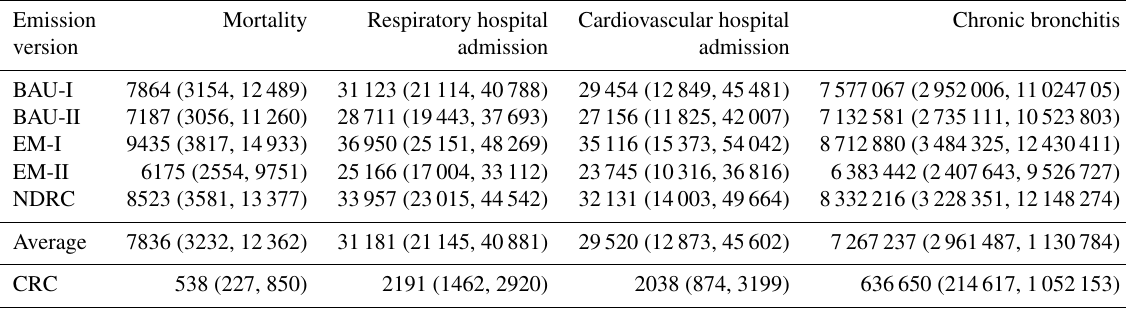
Table 7. Estimated number of cases (95%CI) attributable to agricultural fire smoke PM 2 . 5 exposure in China in 2012.